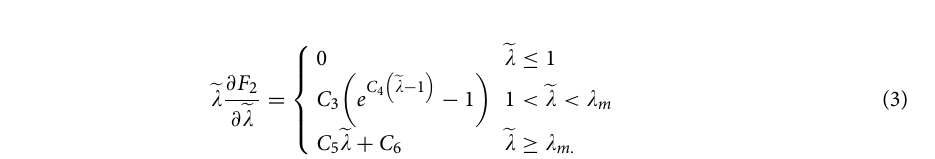
Figure 1. Coupon dimensions and mesh for all ( a ) longitudinal and ( b ) transverse